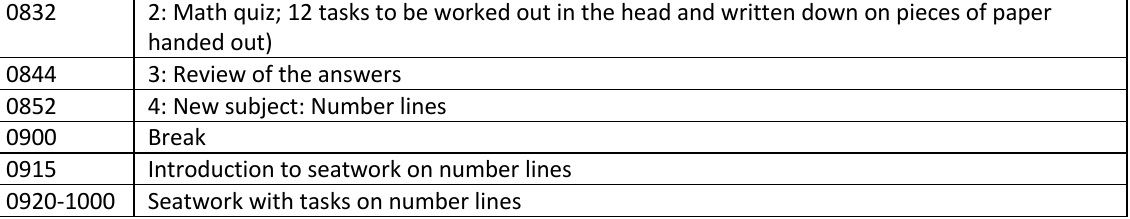
Table 2: Overview of activities in the mathematics